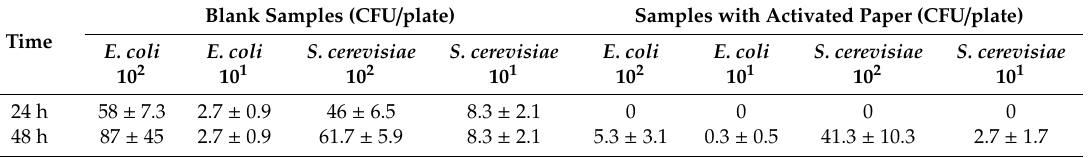
Table 8. Antimicrobial activity (number of colonies, CFU / Petri dish) of E. coli and S. cerevisiae after 24 and 48 h (average of 3 parallels), paper coating 30g / m 2 , 94 mm Petri dish, activation by 3 kg weight, three